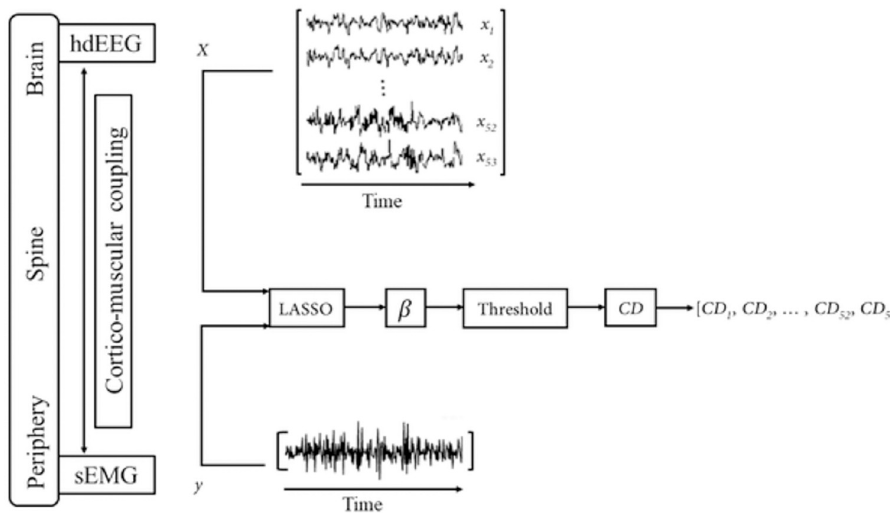
Fig 3. General block diagram of application of sparse analysis (i.e., LASSO method) and extracted coefficients. We schematically tried to show how the multichannel hdEEG data could be projected on each sEMG channel on the right side of the figure. The final CD i coefficients for all EEG channels are utilized as input data for machine learning method. These coefficients demonstrate the coupling values and the contribution of each respective channel in the